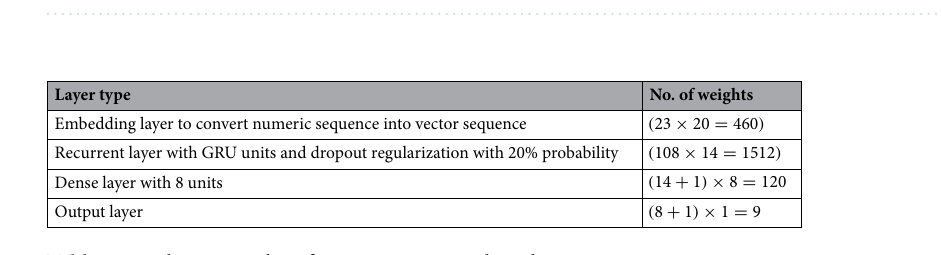
Table 5. CarboxE site identification using RNN based on GRU